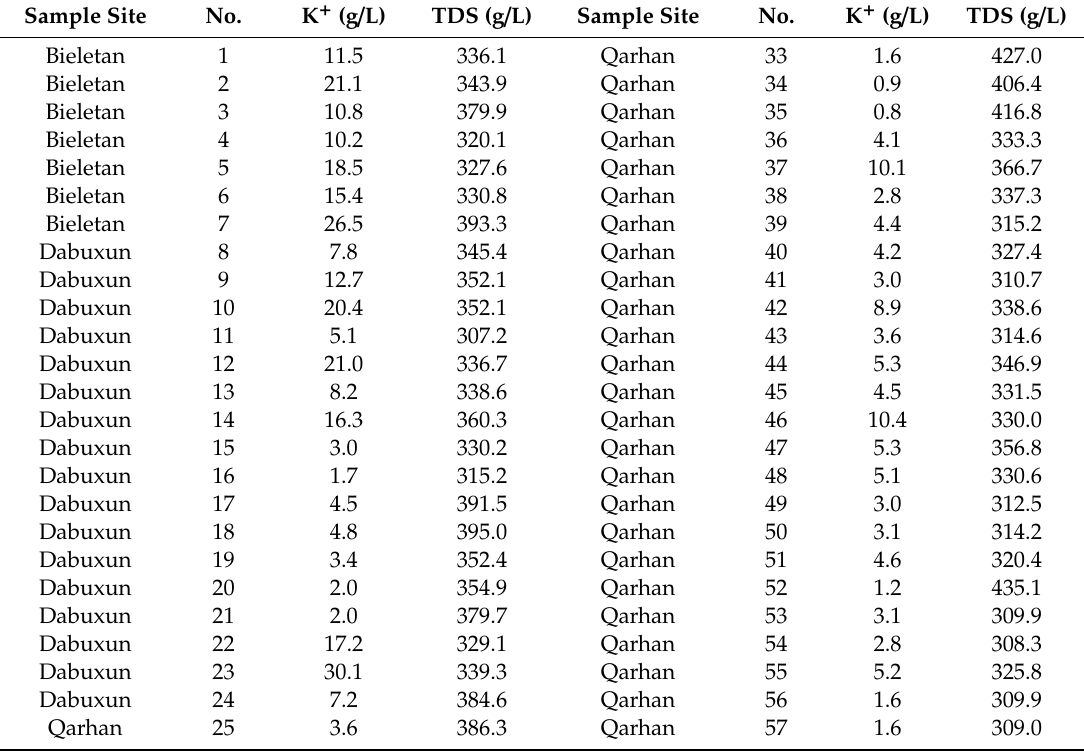
Table 1. The K + concentrations and TDS (total dissolved solids) of the intercrystalline brines in the QSL. Sample